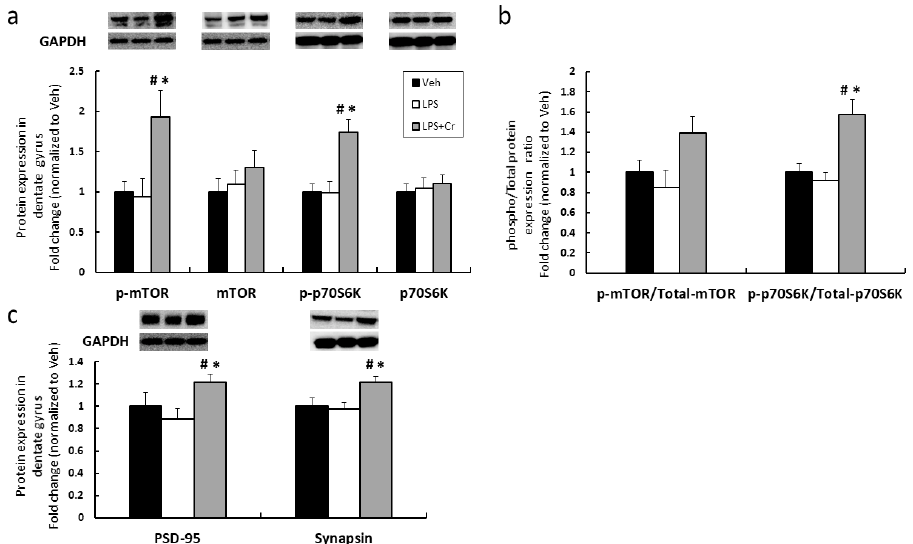
Figure 4. Effects of 6 weeks of Cr supplementation on molecular signaling in dentate gyrus following LPS. ( a ) Proteins expression level of mTORC1 signaling pathway. ( b ) Ratio of phosphorylation/total mTORC1 signaling proteins. ( c ) Synaptic proteins downstream to the mTORC1 signaling. Results are presented as mean ± SEM ( n = 8). # p < 0.05 significantly different from Veh group. * p < 0.05 significantly different from LPS group.